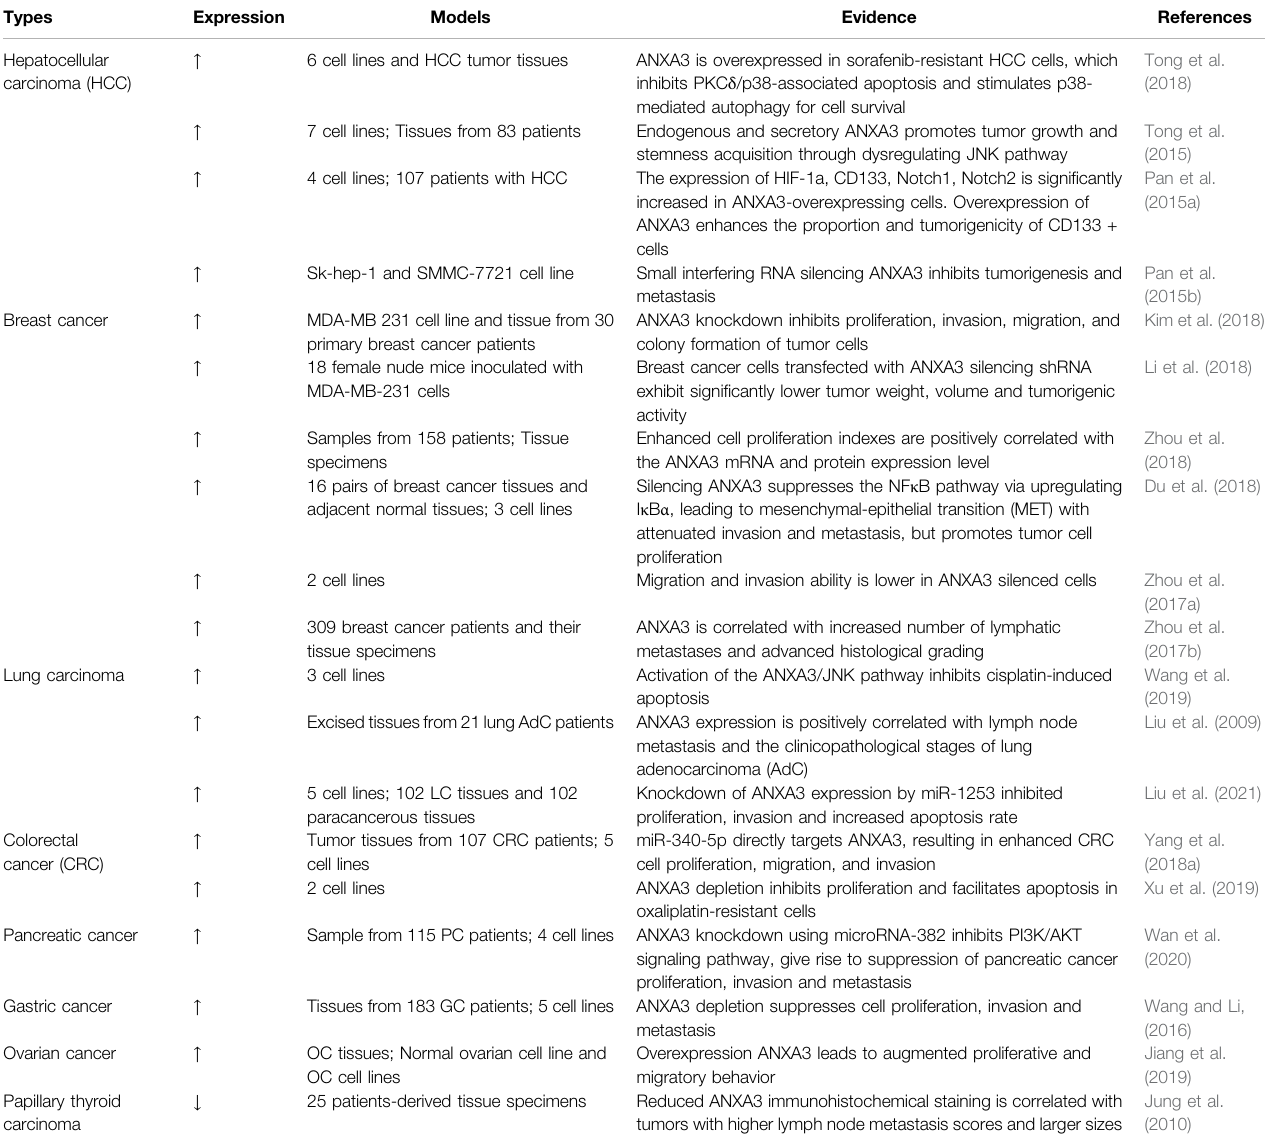
TABLE 1 | The role of ANXA3 in tumor proliferation, invasion and